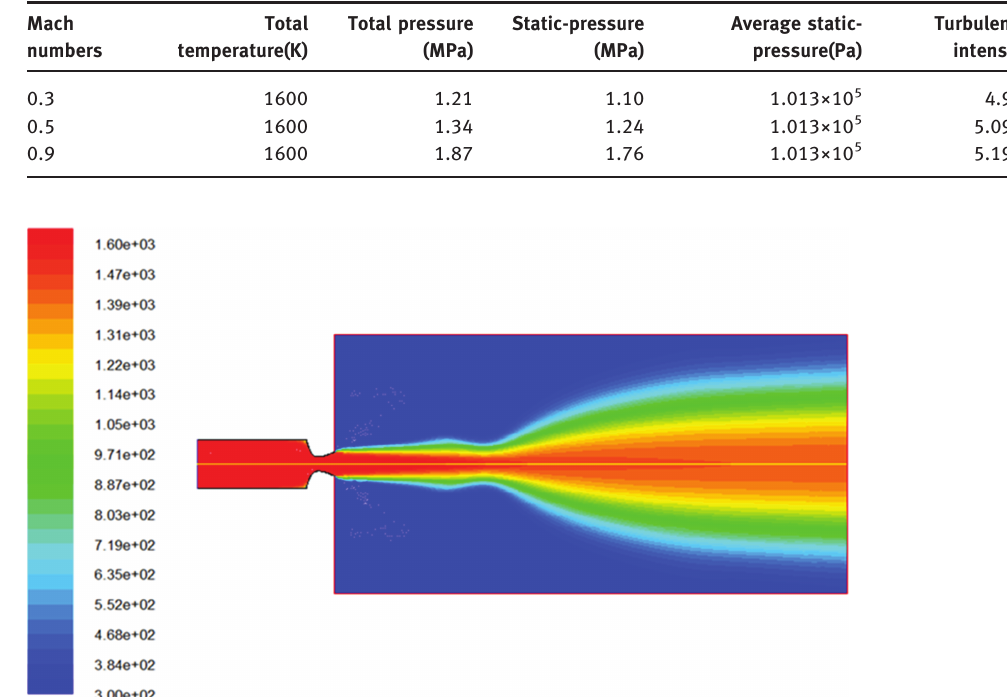
Table 3: The detailed parameters of boundary